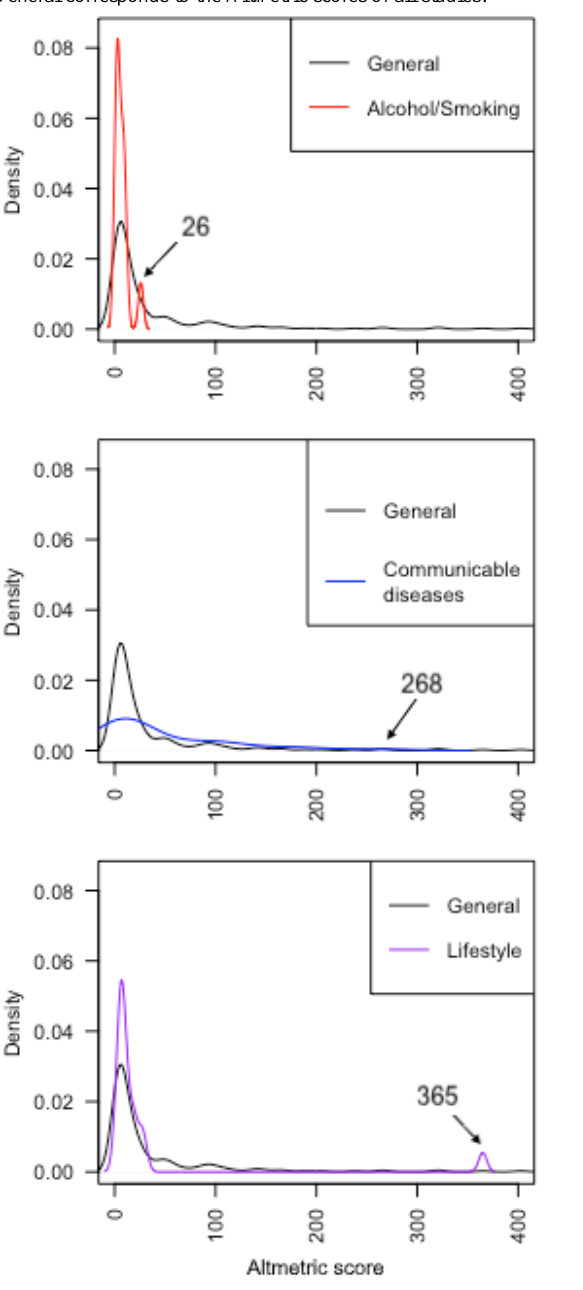
Figure 2. Distribution of Altmetric scores by health research area. Corresponding publications to the indicated Altmetric scores: Alcohol/Smoking: 26 [33]; Chronic diseases: 94 [34], 263 [35], 1090 [36]; Communicable diseases: 268 [37]; Mental health: 47 [38]; Lifestyle: 365 [39]; Other: 59 [40], 145 [41]. General corresponds to the Altmetric scores of all